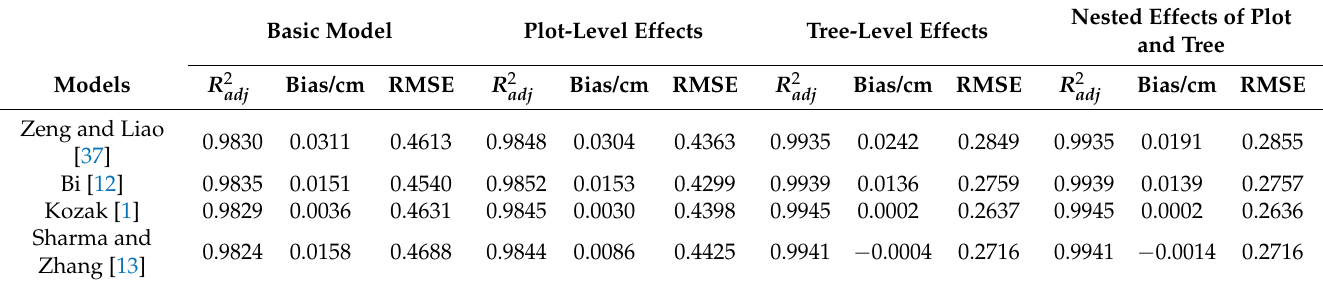
Table 6. Model fitting statistics of variable exponent taper models with different